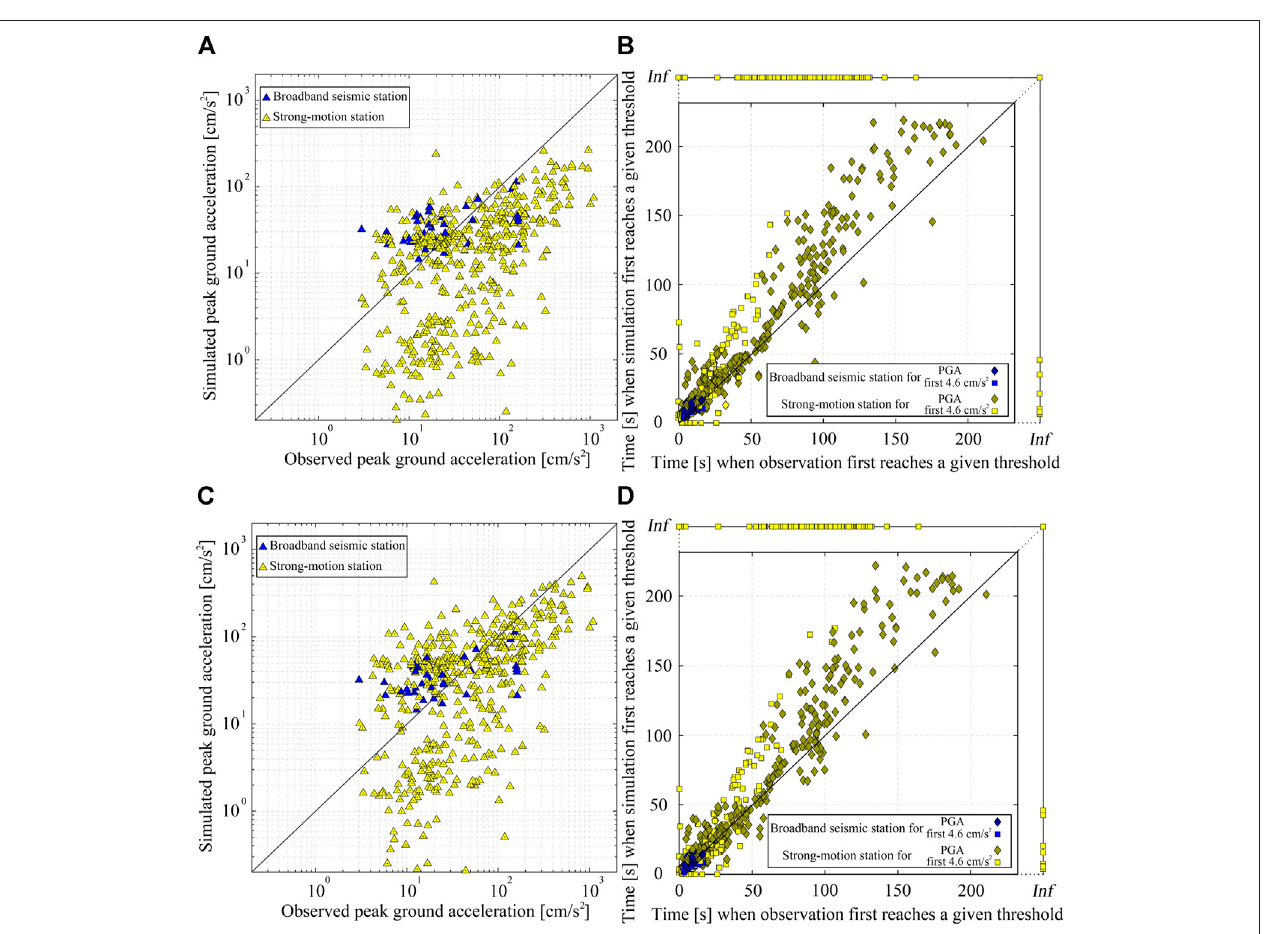
FIGURE4| Comparison ofobservedandsimulatedwaveformsforthe58studiedearthquakesintermsof (A) peakgroundacceleration(PGA)amplitudes and, (B) the time when they fi rst reach PGA and 4.6 cm/s 2 (which we will later use as a trigger threshold for FinDer), respectively, before correction. Inf means that the three- component records of the corresponding station never reach this threshold. (C) and (D) show the same comparison after amplitude and time correction.